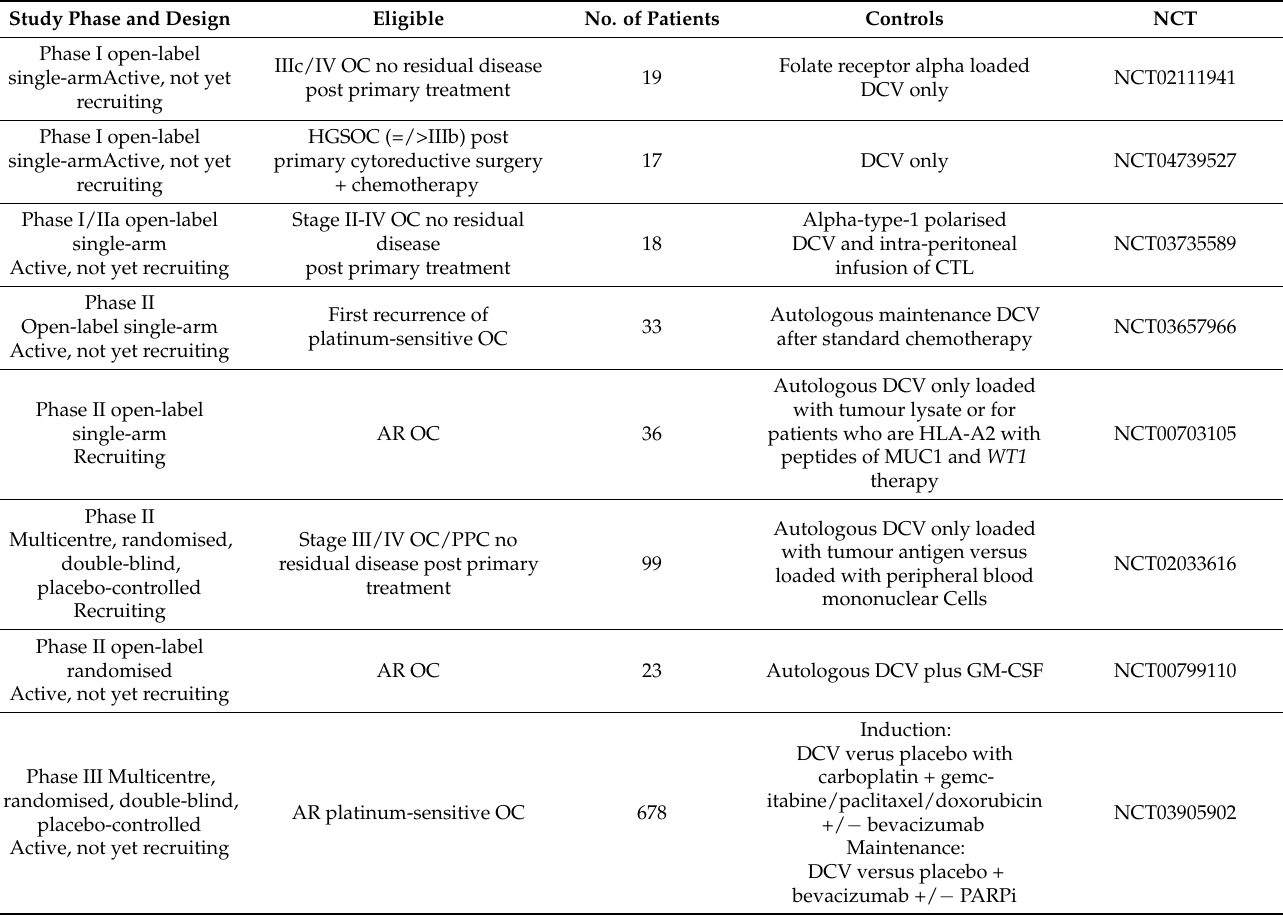
Table 3. Clinical trials in ovarian cancer using dendritic cell-based vaccines